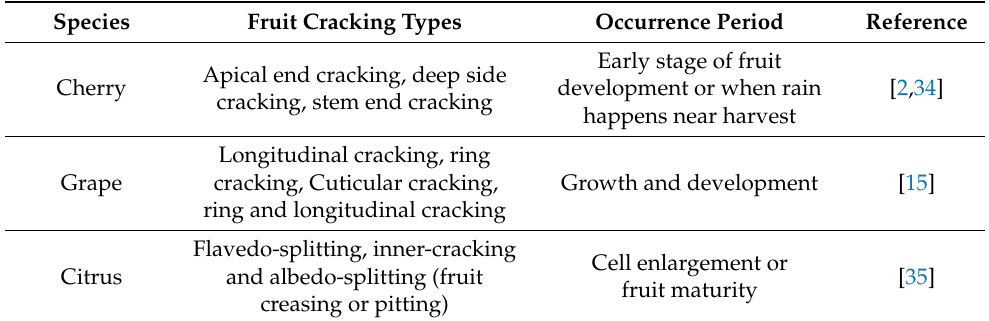
Table 1. Fruit cracking types and occurrence period in horticultural plants.